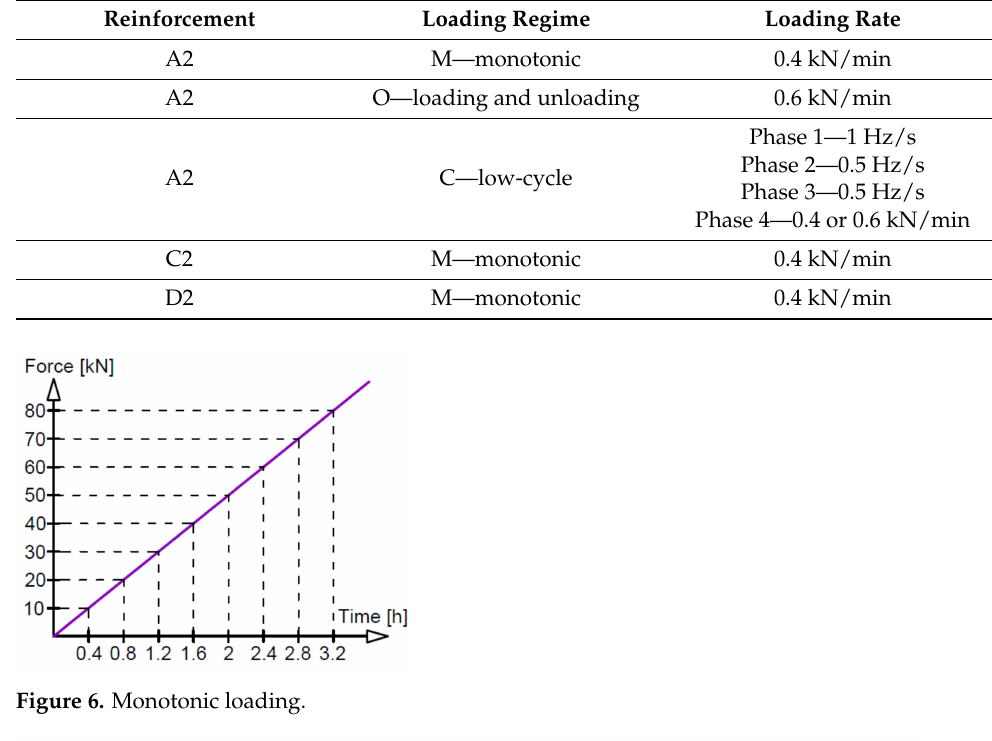
Table 2. Loading program and rate for the members under test.